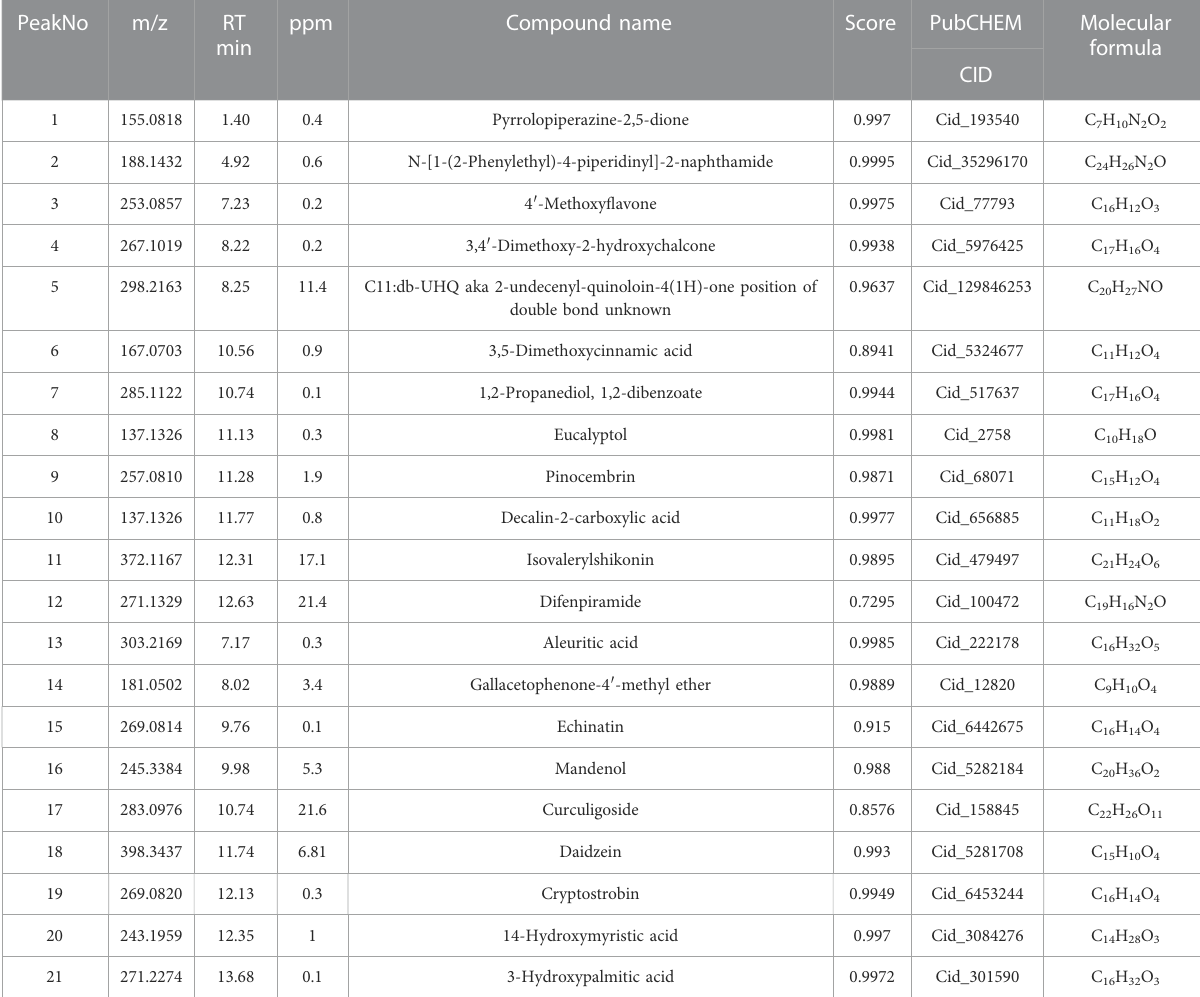
TABLE 2 The top 21 compounds of ZZO by UPLC-HRMS